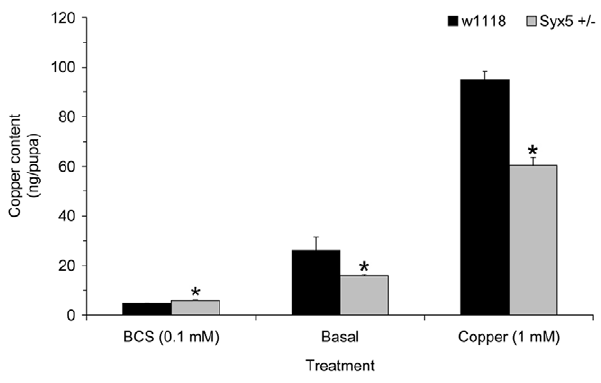
Figure 2. Copper accumulation in Syx5 + / 2 Drosophila . Copper content was measured by ICP-AES in wild-type and Syx5 + / 2 Drosophila reared to the pupal stage on copper chelator (100 m M BCS), basal media or 1 mM copper. Values are mean metal content per pupa with s.e.m. from five replicates of 50 pupae. Syx5 + / 2 larvae accumulate less copper on both basal and copper-supplemented media. *Significant difference from wild-type, determined by a Mann-Whitney test (P , 0.05).